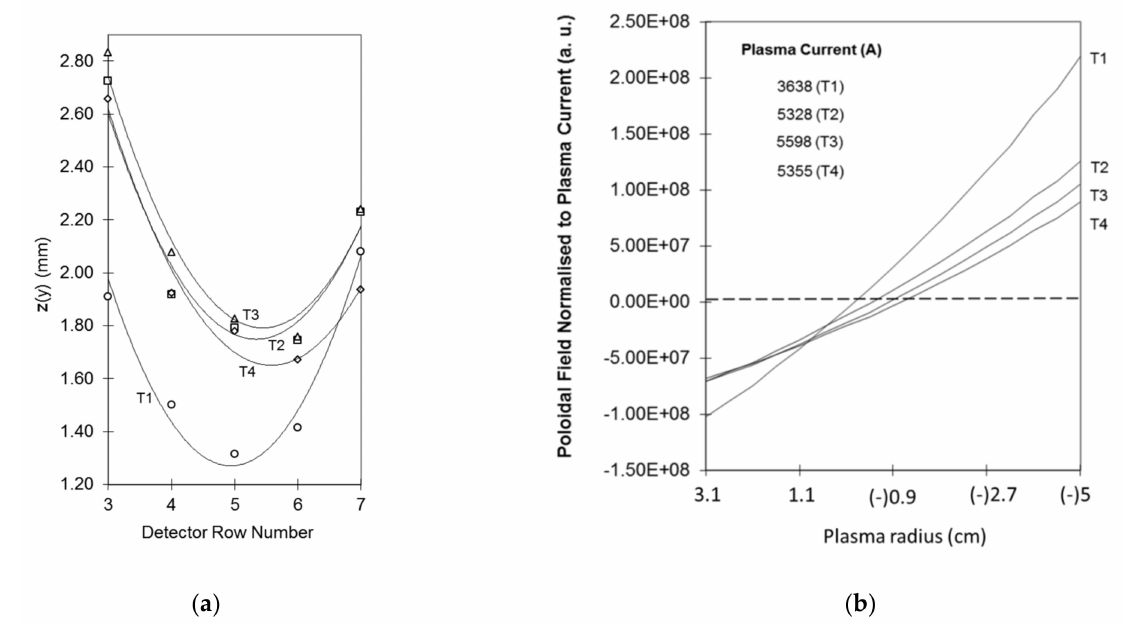
Figure 22. ( a ) The symbols indicate the measured z-positions of the secondary beams fitted with corresponding interpolation lines T1, T2, T3 and T4. ( b ) Estimated normalized poloidal field profiles from the detector characteristic lines at the time instantes T1, T2 T3 and T4 (reprinted from